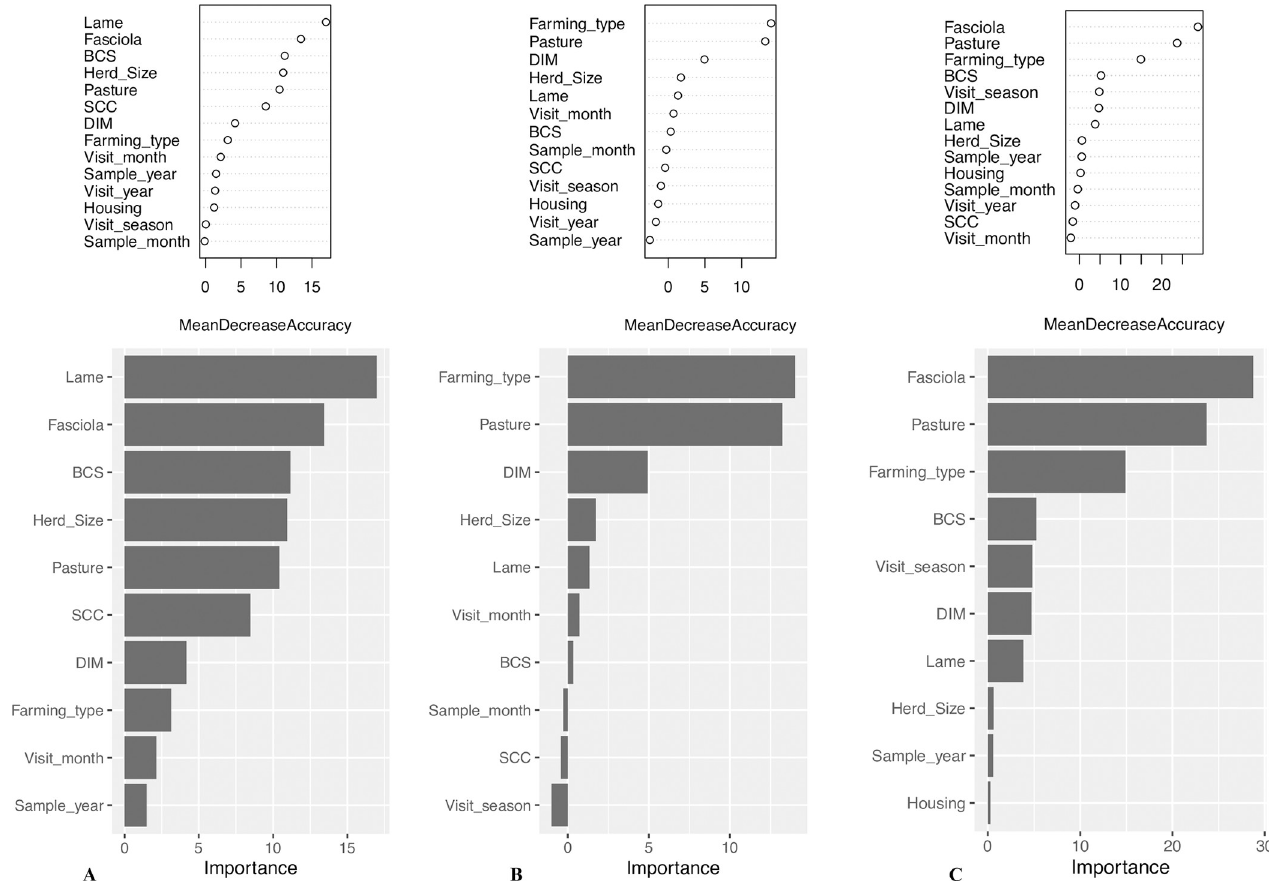
Fig 4. Mean decrease accuracy plots and variable importance plots for the random forest classification process of clusters 1 and 2 in study regions North and South ( O . ostertagi analyses). A: study region North. B: study region South. C: study region South. Changes of prediction accuracy, i. e. decrease of prediction accuracy if excluding single variables. In region North the first eight factors are the most valuable ones characterising clusters compared with the remaining variables. In study regions East and South, the first three variables were the most important ones differentiating clusters.